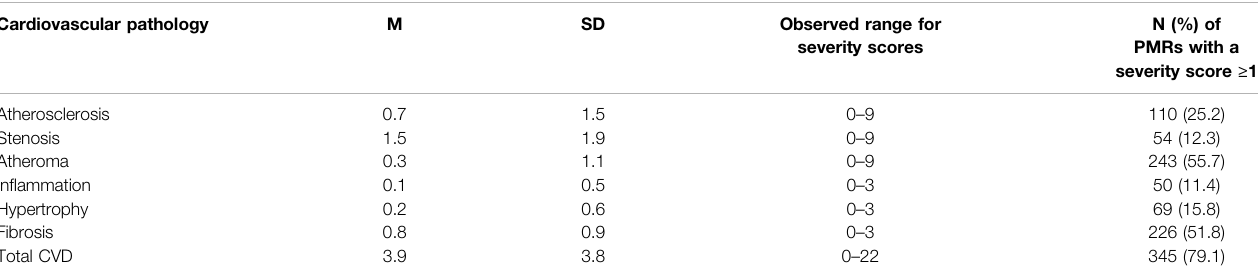
TABLE 3 | Severity scores for cardiovascular pathologies identi fi ed in 436 Post-mortem Reports (PMRs). Cardiovascular